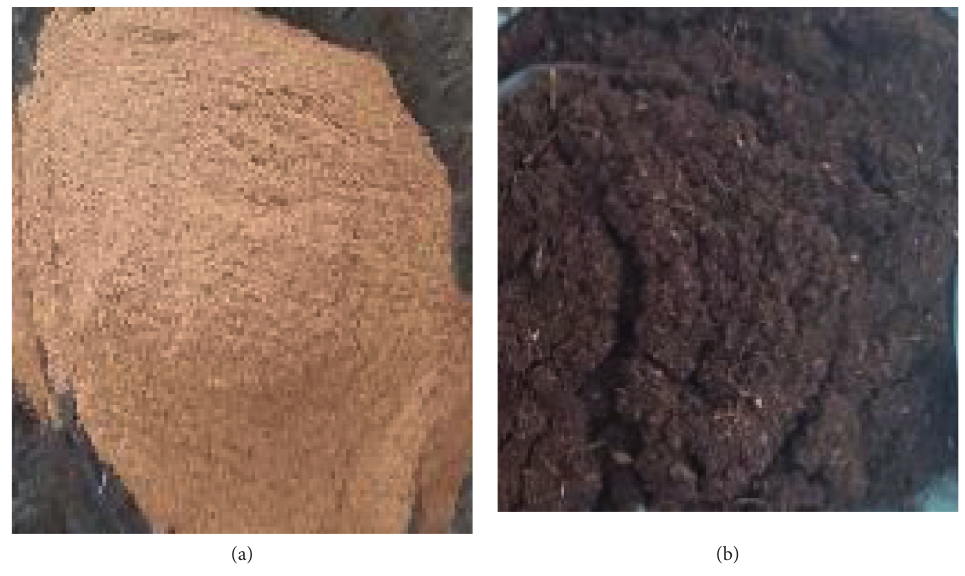
Figure 1: Photograph of adsorbents: (a) PSS and (b)